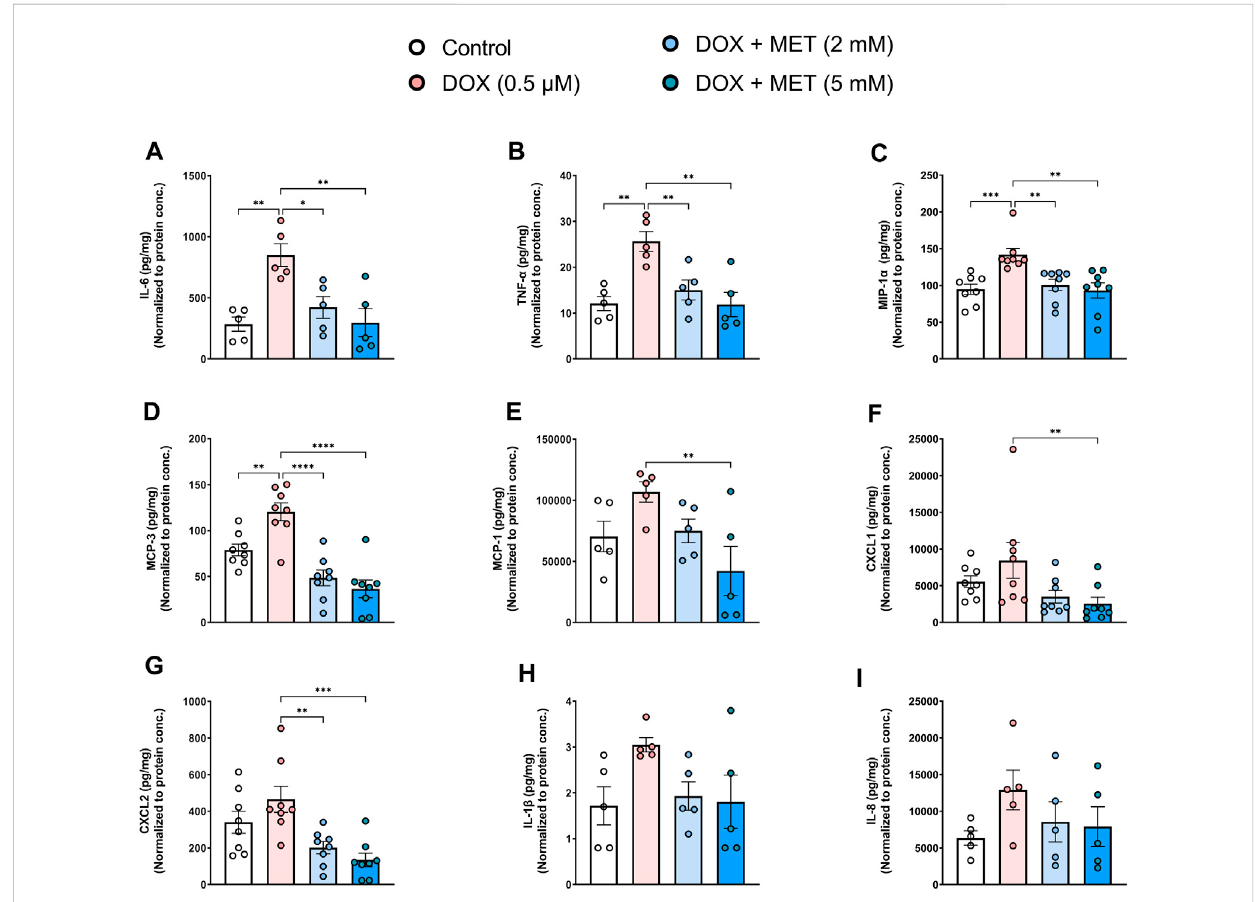
Metformin decreased DOX-induced SASP factors in conditioned media of HUVECs. HUVECs were treated for 24 h with 0.5 µM DOX ± metformin (2 and 5 mM, added 24 h before DOX). Thereafter, DOX was removed and the cells were incubated in DOX-free media with or without metformin for an additional 72 h. Conditioned media were collected and the protein expression of SASP factors including IL-6, TNF- α , MIP-1 α , MCP-3, MCP-1, CXCL1, CXCL2, IL-1 β , and IL-8 [ (A – I) , respectively (n = 5 – 8)] was determined by Luminex multiplex platform. Values were normalized to the protein concentration of the cells determined by BCA. Values are shown as means ± SEM. Data were analyzed by one-way ANOVA followed by a Dunnet ’ s multiplecomparisonstest(Figures2A,B,D – E,G,I)ornon-parametricKruskal – WallistestsfollowedbyDunn ’ s posthoc test(Figures2C,F,H);* p <